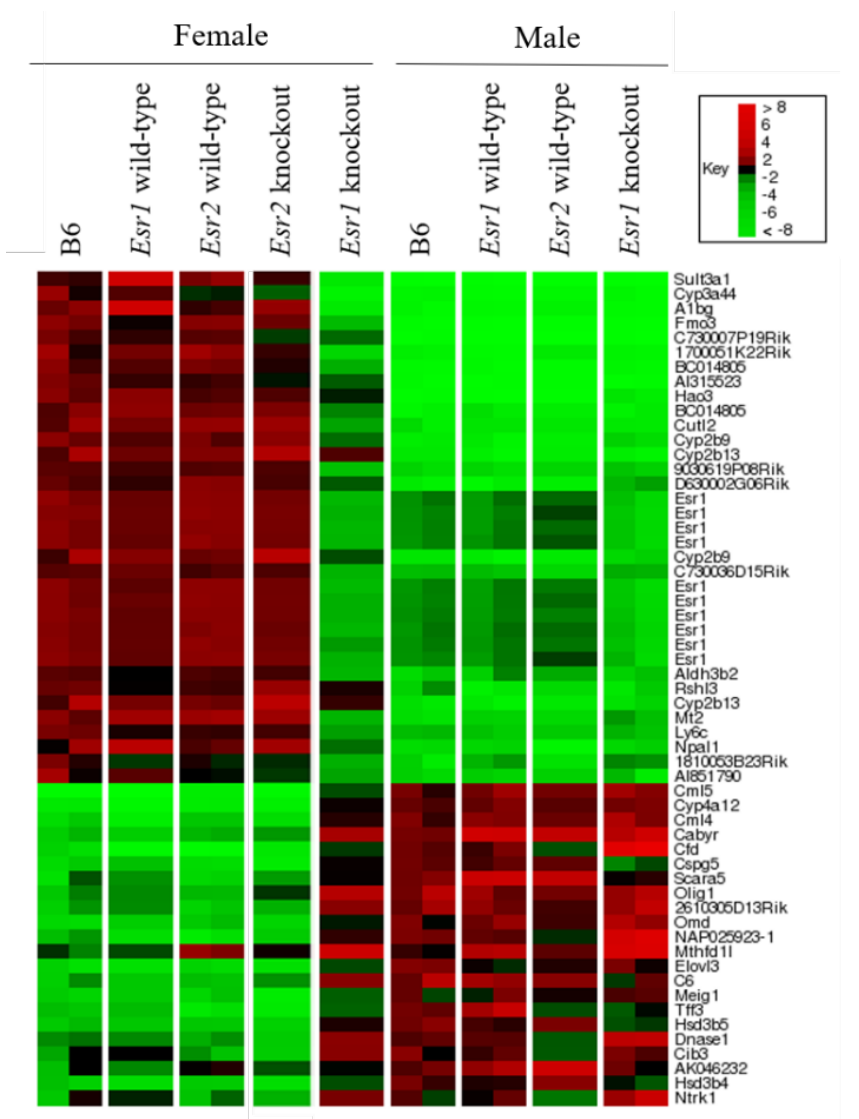
Figure 1. Estrogen Receptor- α knockout females, but not Estrogen Receptor- β knockout females, show male-specific liver gene expression. This heat map shows Estrogen Receptor- α ( Esr1 ) regulated transcripts in female mice that differ at least 5-fold compared to wild-type (WT) female littermates. Each lane represents microarray results from a pool of livers from individual mice sacrificed at 9–10 weeks of age. Duplicate arrays are shown for each group. WT females are represented by the first three lanes. Lane 1: C57BL/6J (B6) females ( n = 18). Lane 2: WT littermates of Estrogen Receptor- α knockout ( Esr1 KO) mice ( n = 6). Lane 3: WT littermates of Estrogen Receptor- β knockout ( Esr2 KO) mice ( n = 6). Lane 4: Esr2 KO females ( n = 8). Lane 5: Esr1 KO females ( n = 6). WT males are represented by lanes 6–8. Lane 6: B6 males ( n = 15). Lane 7: WT littermates of Esr1 KO mice ( n = 6). Lane 8: WT littermates of Esr2 KO mice ( n = 6). Lane 9: Esr1 KO males ( n =